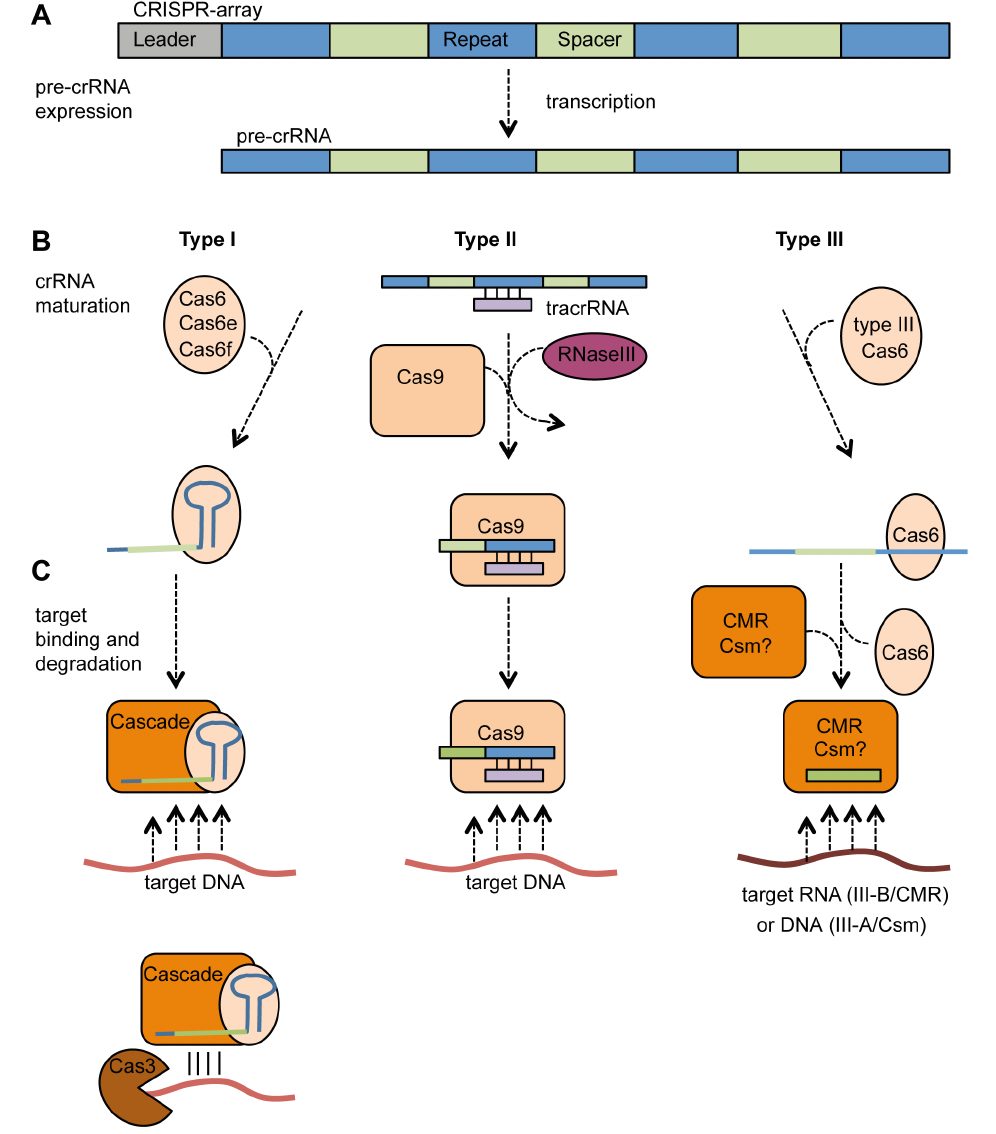
Figure 3. crRNA generation and target interference in type I, II and III CRISPR/Cas systems . ( a ) Transcription of the CRISPR array into a pre-crRNA; ( b ) Processing of the pre-crRNA into mature short crRNAs. In type I, RNA cleavage is performed by Cas6- homologues, which bind the repeat stem-loop and stay associated for Cascade formation. In type II, tracrRNA is required for binding and processing of the pre-crRNA by Cas9 and RNaseIII. In type III, Cas6 binds to non-structured repeats and processes the pre-crRNA into crRNA and then dissociates; ( c ) Target binding and cleavage. Type I Cascade binds the DNA target before recruiting Cas3 for degradation. In type II, Cas9 stays associated with the tracrRNA:crRNA complex after processing and subsequently binds and cleaves target DNA. The type III-B CMR-complex binds spacer sequence and targets RNA. It is hypothesized that a type III-A Csm complex forms and this system targets